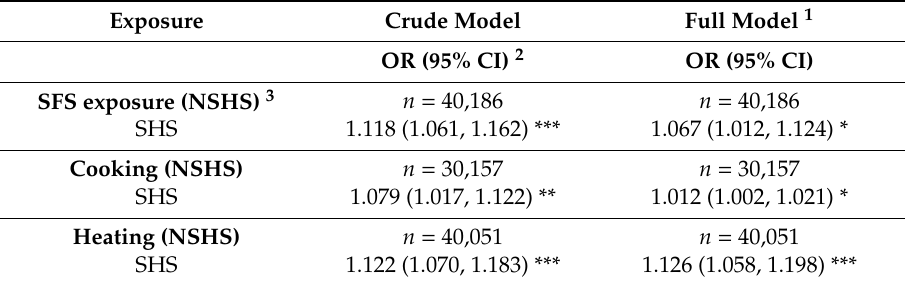
Table 4. Risk of co-exposure to SFS among children with SHS